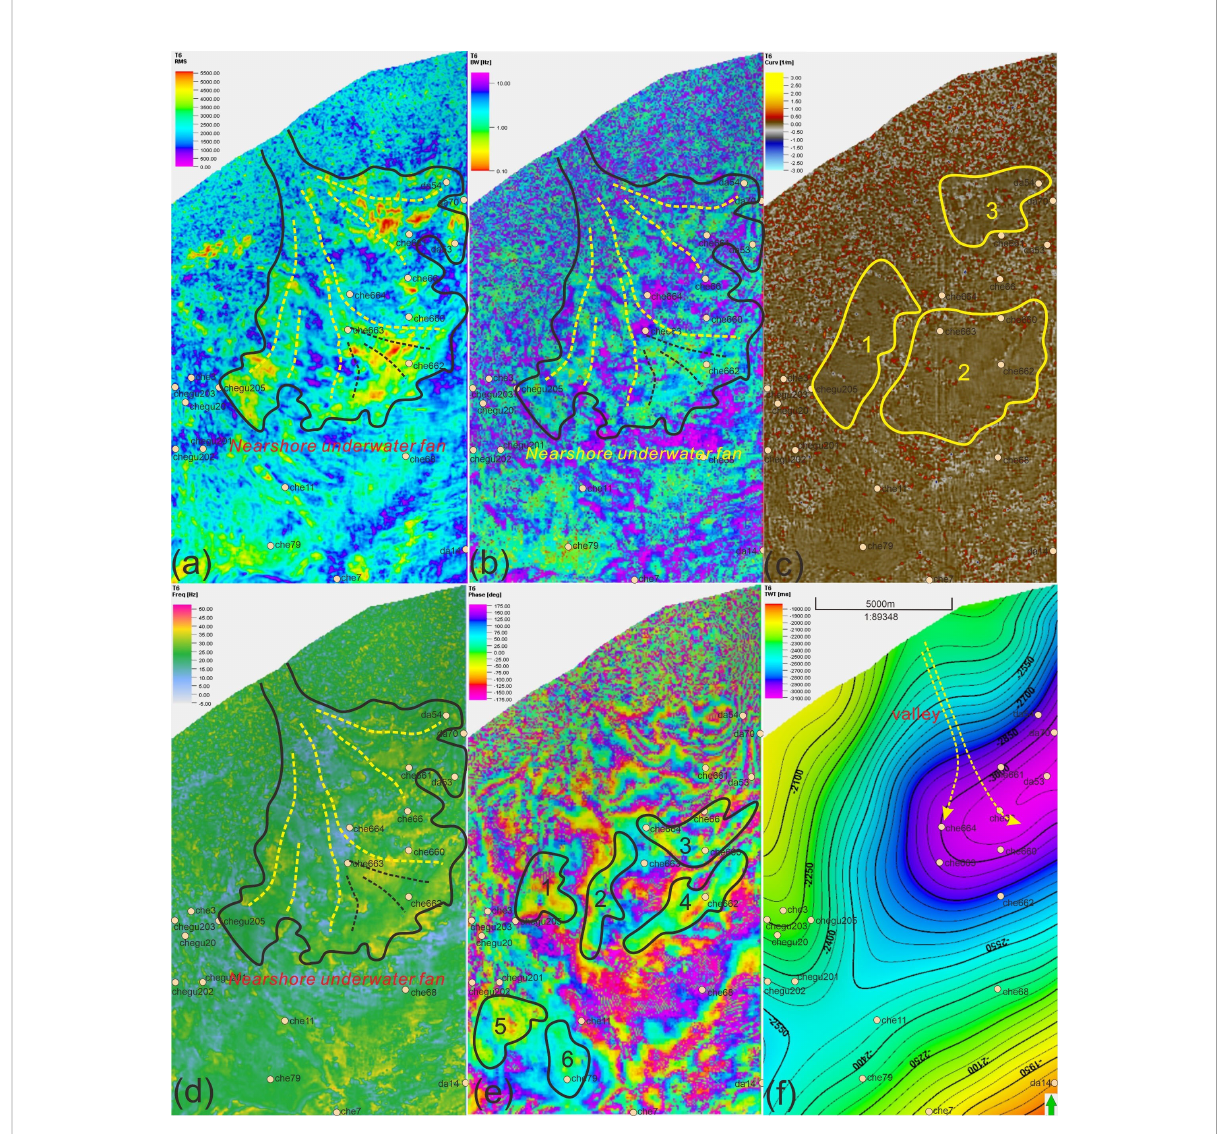
FIGURE 8 Plan of fi ve attributes of P 2 S 3X . (A) RMS attribute. The black curve is the boundary of the nearshore area under the fan, and the yellow and black dotted lines are river channels. (B) BW attribute. The black curve is the boundary of the nearshore area under the fan, and the yellow and black dotted lines are river channels. (C) Curv attribute. The yellow curve is the boundary of gravelly sandstone deposition. (D) Freq attribute. The black curve is the nearshore boundary under the fan, and the yellow and black dotted lines are river channels. (E) Phase attribute. The black curve is the predicted boundary of gravelly sandstone deposition. (F) The two-way-time contour map. The terrain in the northern area is high, the terrain in the southern area is high, and the terrain in the middle area is low. Therefore, there is a depression in the middle. Sediments were transported from high to low along the river channel and deposited on the slope zone and lake